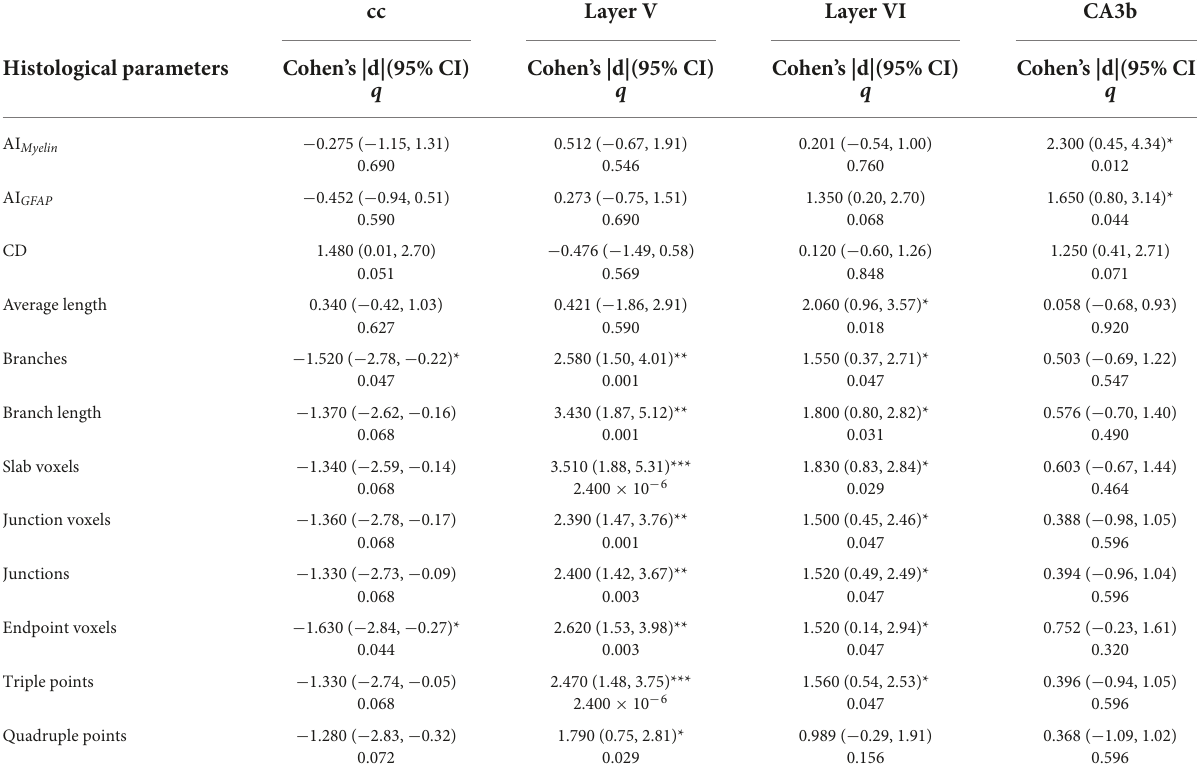
TABLE 2 Effect of SE-induced brain damage in quantitative ROI-based analyses of histological parameters.